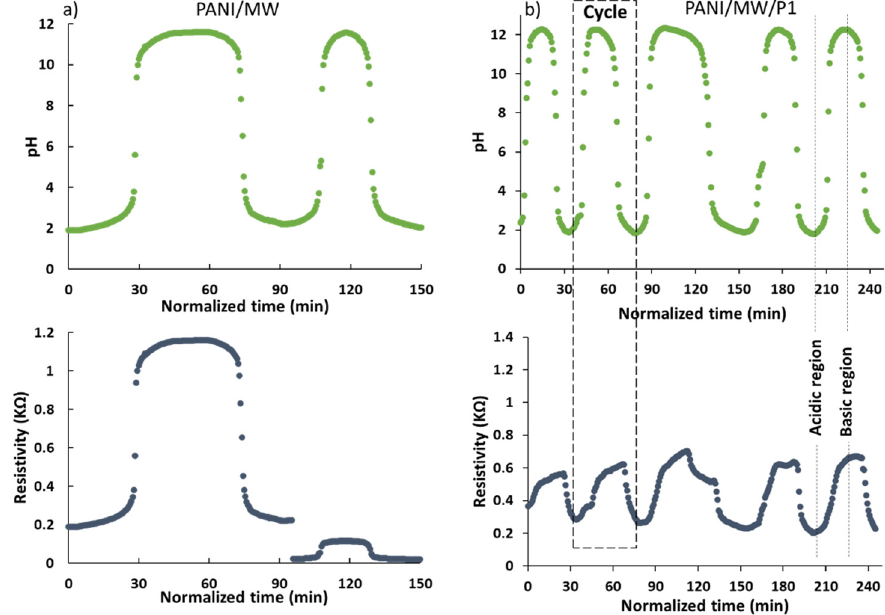
Figure 5. Changes in resistivity as a function of pH over time in the ( a ) PANI/MW and ( b ) PANI/MW/P1 samples. ( b ) PANI/MW/P1